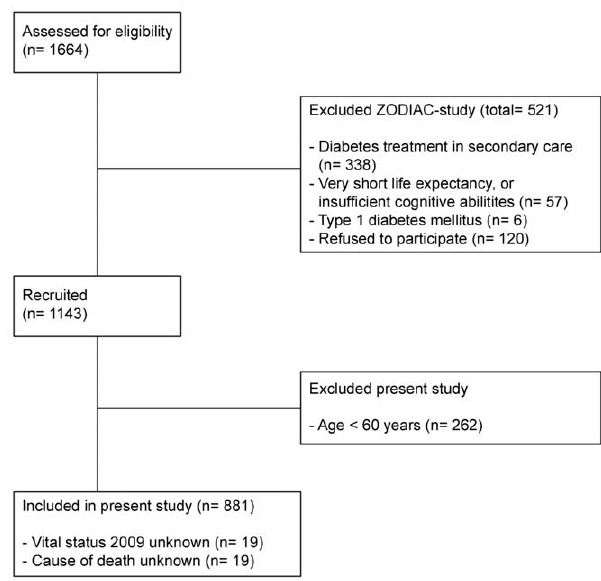
Figure 1. Flow diagram showing the selection process of the ZODIAC and the present